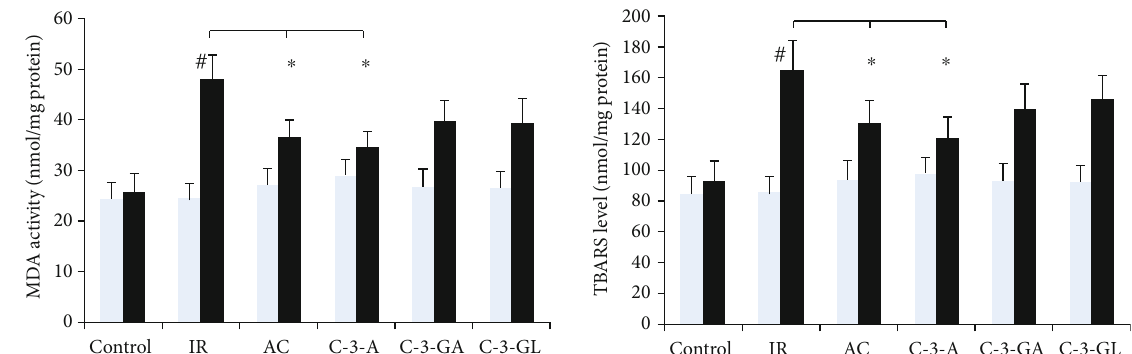
Figure 7: Lipid peroxidation markers in the kidney of the renal IR injury and anthocyanin treatment. The data are the means ± SD . n = 13 per group. MDA: malondialdehyde; TBARS: thiobarbituric acid reactive substance; IR: ischemic reperfusion; AC: anthocyanins; C-3-A: cyanidin- 3-arabinoside; C-3-G: cyanidin-3-glucodise; C-3-GA: cyanidin-3-galactoside. # P < 0 : 01 vs. control within group; ∗ P < 0 : 05 vs. respective IR